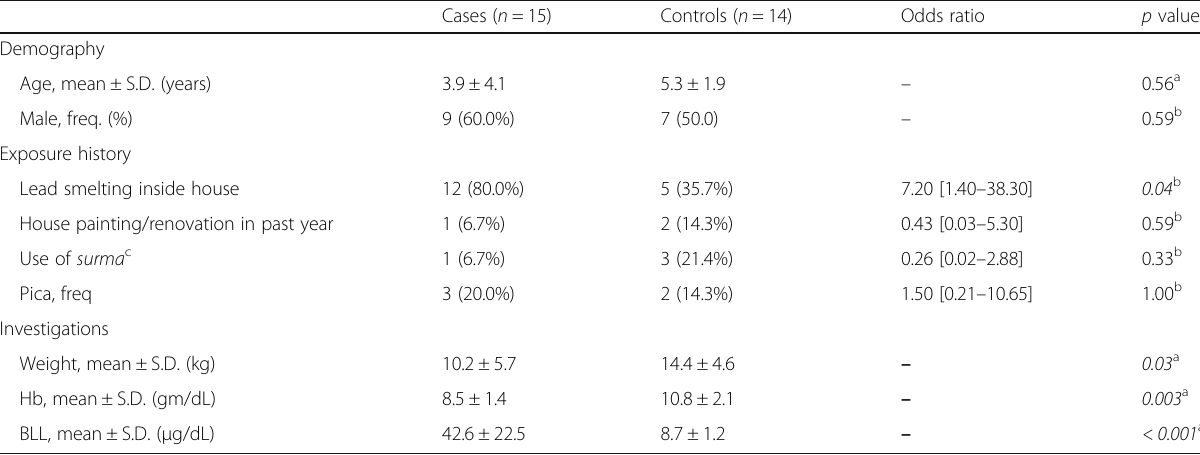
Table 1 Characteristics of cases and controls